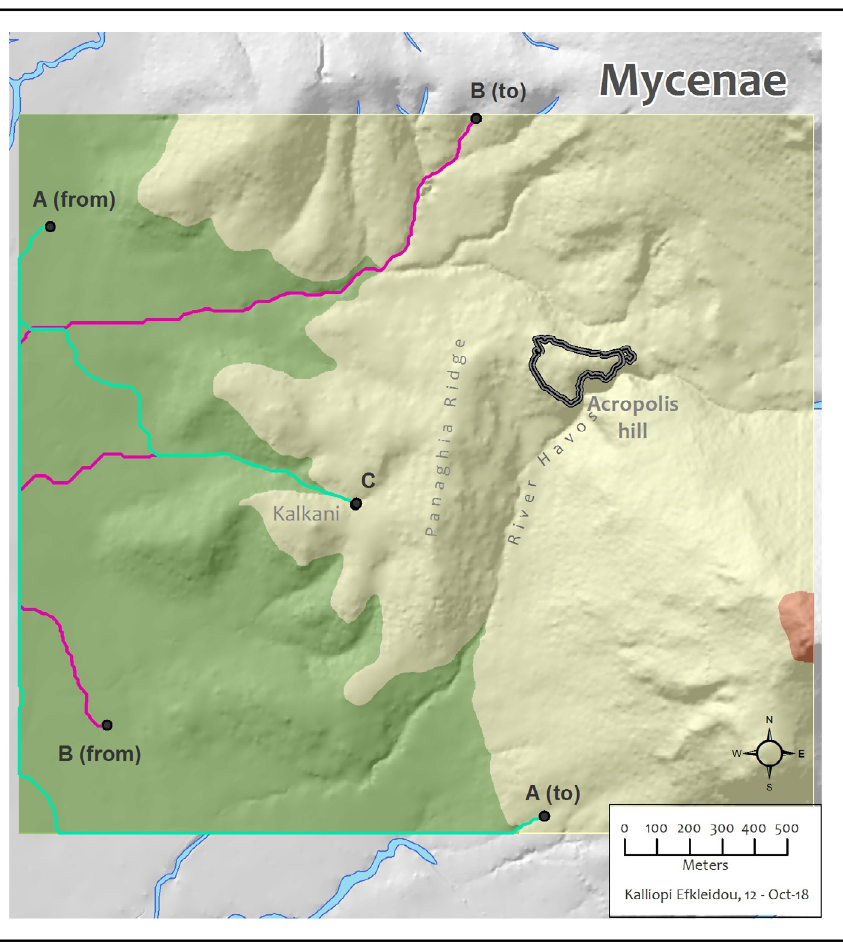
Figure 6. The LCPs based on an 8% critical slope raster from point A (from) to points A (to) and C and from point B (from) to points B (to) and C based on an 8% critical slope